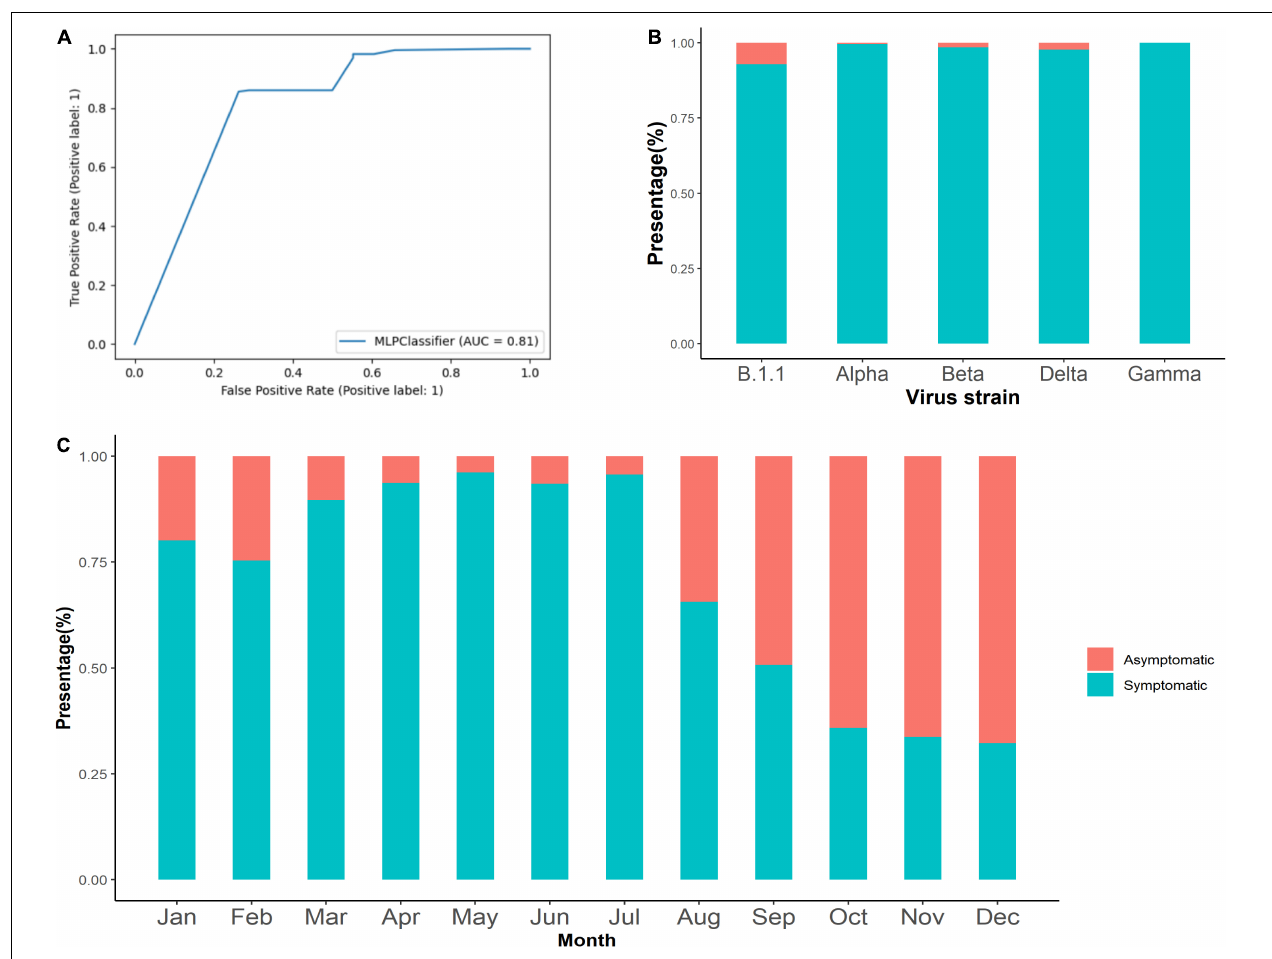
FIGURE 5 | To predict the clinical outcome among SARS-CoV-2 and pandemic strains. (A) The ROC curve of the model calculated with the 1,329 samples. (B) The percentage of different clinical outcomes among the B.1.1, Alpha, Beta, Delta, and Gamma strains. (C) The percentage of different clinical outcomes from January 1, 2020, to December 31, 2020. SARS-CoV-2, severe acute respiratory syndrome coronavirus 2; ROC, receiver operating